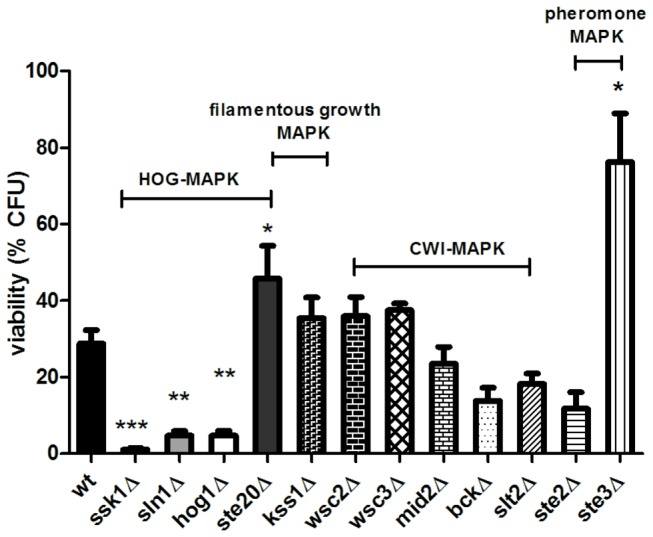
The MAP kinase pathways are involved in the sensitization of S. cerevisiae to C2-phytoceramide.Survival of wild type W303-1A cells and of mutant strains after exposure to 30 µM C2-phytoceramide for 120 min. (ssk1Δ, P<0.0001, sln1Δ, P<0.0001 hog1, P<0.01 and ste20Δ, P<0.05), (ste3Δ, P<0.05), One-Way ANOVA. Data are given as mean ± SE of at least 3 independent experiments, with 5 replicas in each experiment.